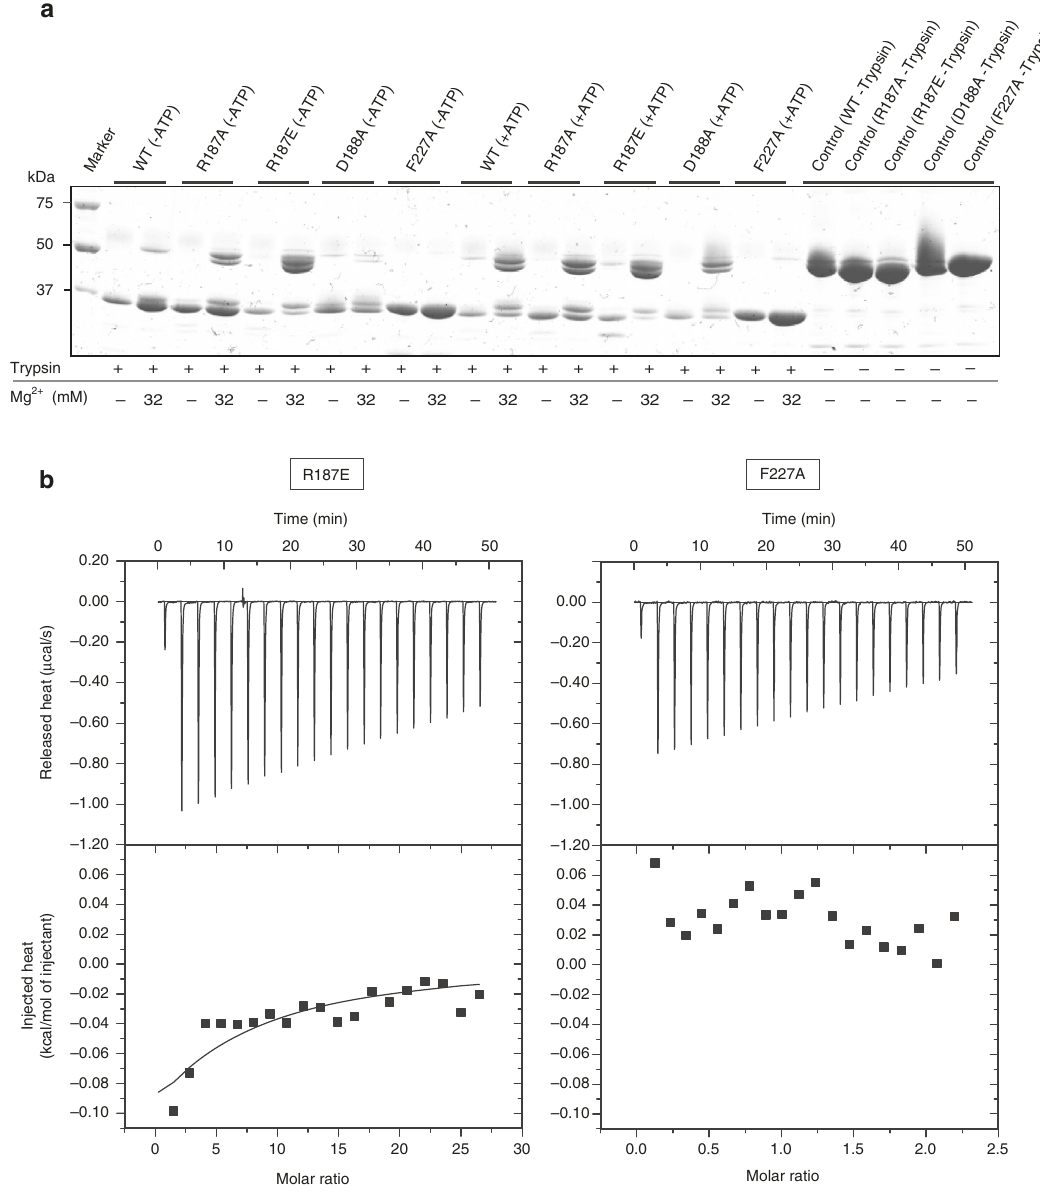
Fig. 4 Biochemical analyses of the ATP-binding site mutants of MgtE. a Protease protection of the MgtE mutants by Mg 2+ and ATP. Protease protection of wild type MgtE by Mg 2+ and ATP is shown as a reference. The numbers on the left side indicate the molecular masses (in kilodaltons) of the markers. b ITC data of the F227A and R187E mutants with ATP. The raw ITC data and the plots of injected heat for 20 automatic injections of 10 mM nucleotide solution into the sample cell containing the MgtE solution are shown. Measurements were repeated twice, and similar results were